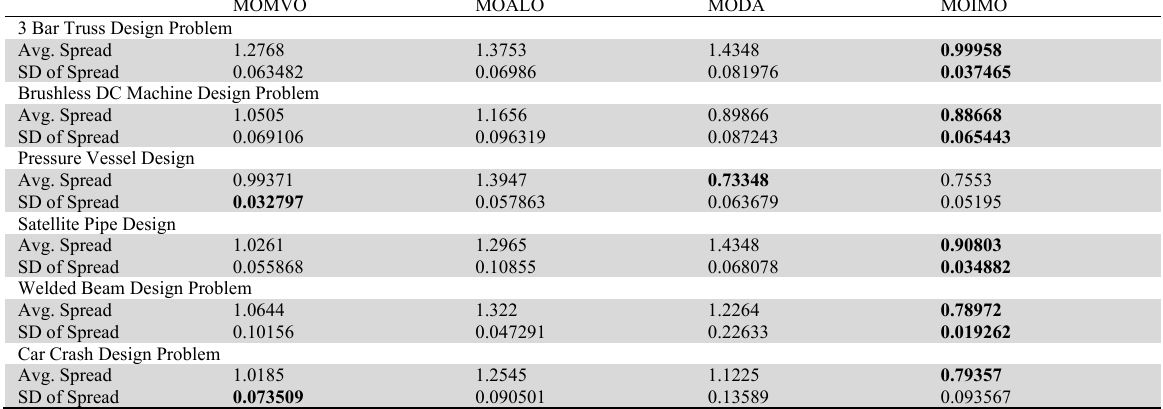
Outcomes of the multiobjective algorithm (Spacing) on the engineering design functions MOMVO